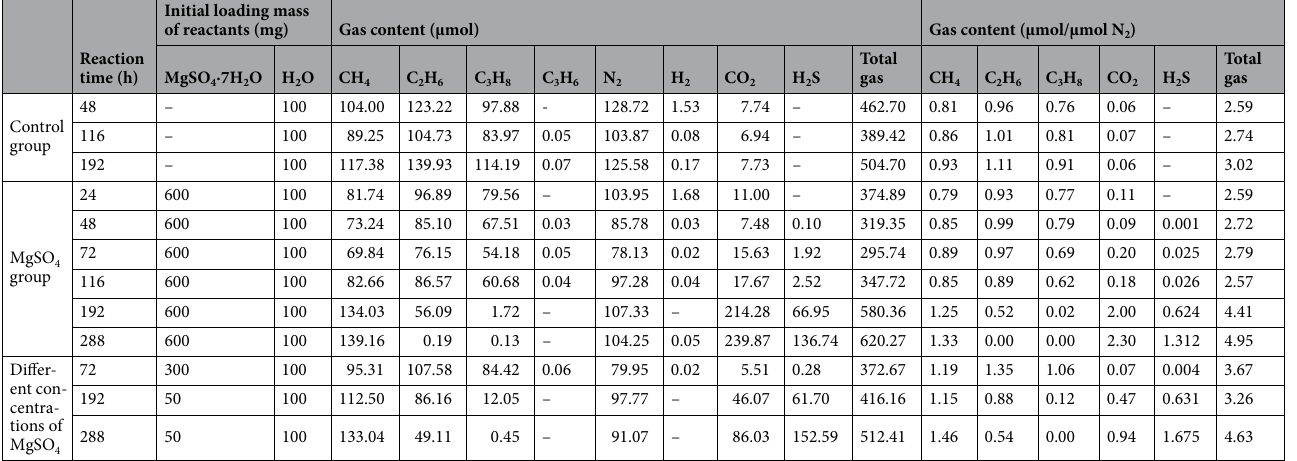
Table 2. Chemical composition of gas products in hydrothermal pyrolysis of different experimental conditions.